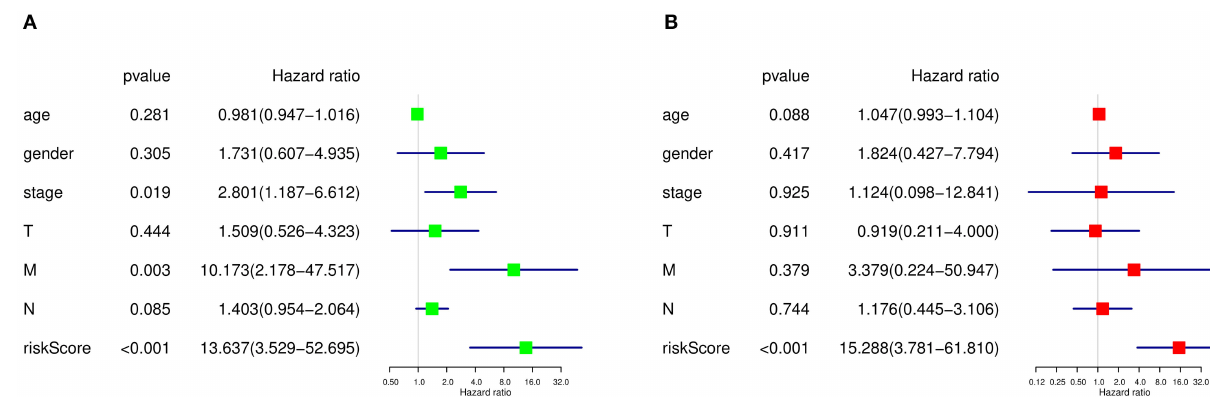
(47, 48), ulceration (47, 49, 50), mitotic rate (47, 51),